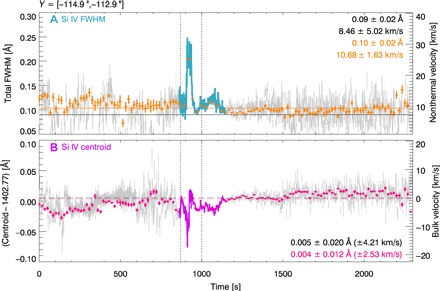
Temporal evolution of Si IV 1402.77 Å.(A) FWHM (nonthermal velocity, vnth) and (B) centroid position (bulk velocity, v) over the spatially integrated region of Y between −114.9″ and −112.9″ for all times observed by IRIS during the observation (gray) and the flare time [turquoise (A) and purple (B)]. In (A), the nonthermal velocity in the region before and after the flare is shown in the legend, calculated for the raster time resolution (black) and a time binned case (orange). In (B), the determined Si IV reference wavelength in the region plus its uncertainty is shown in the legend for the raster time resolution (black) and a time binned case (pink).